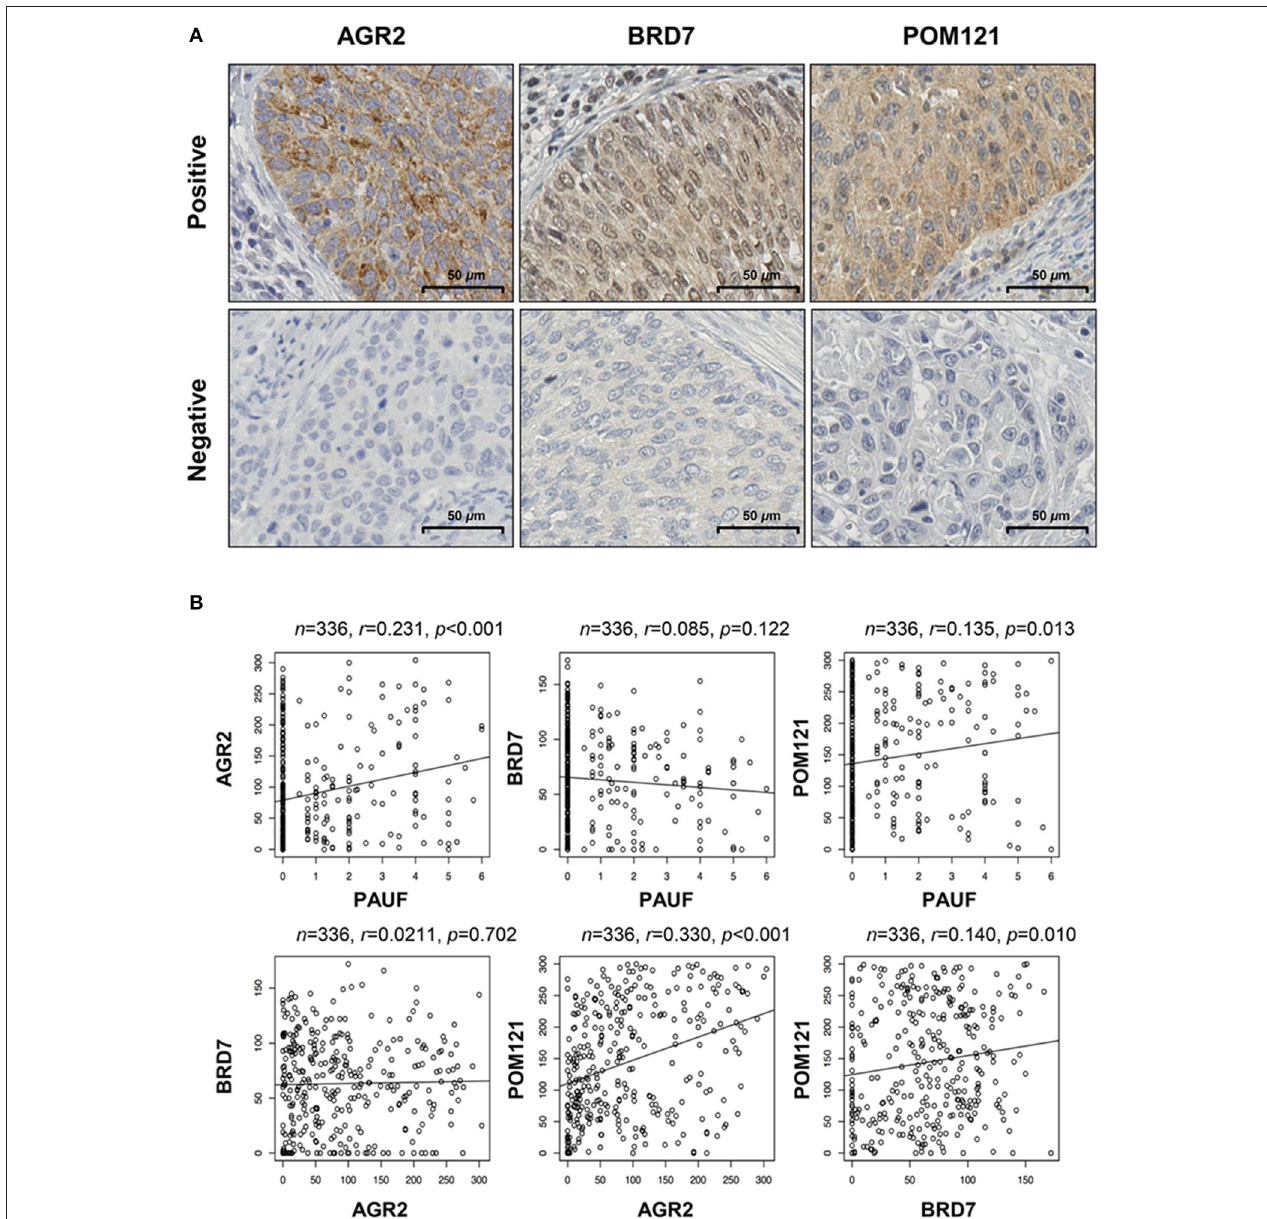
FIGURE 2 | Expression of the PAUF-associated proteins AGR2, BRD7, and POM121 in patients with cervical cancer. (A) Representative examples of positive and negative expression of the AGR2, BRD7, and POM121 proteins. The scale bar represents 50 µ m. (B) Correlations between expression of PAUF and PAUF-related proteins in cervical cancer tissues. AGR2 protein expression was positively correlated with POM121 expression ( r = 0.33, p < 0.001).